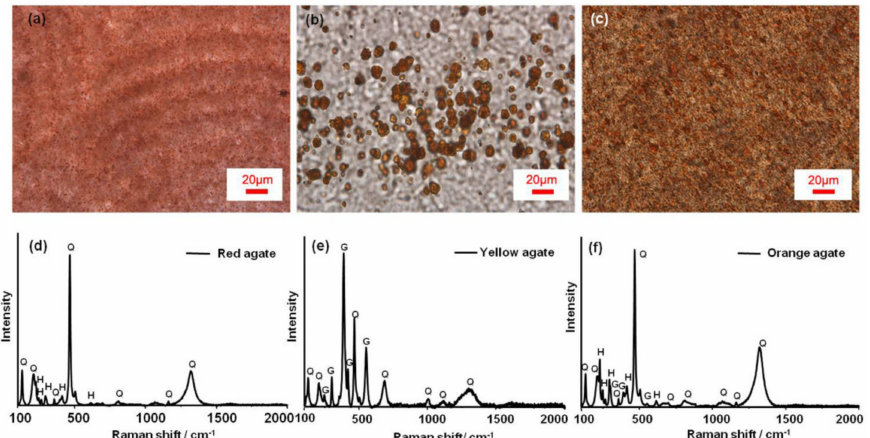
Figure 3. Micrographs of yellow goethite and red hematite of Xuanhua-type agate. ( a ) Hematite in the red agate; ( b ) goethite in the yellow agate; ( c ) mixture of hematite and goethite in the orange zone; ( d – f ) Raman spectra of red agate, yellow agate and orange agate,